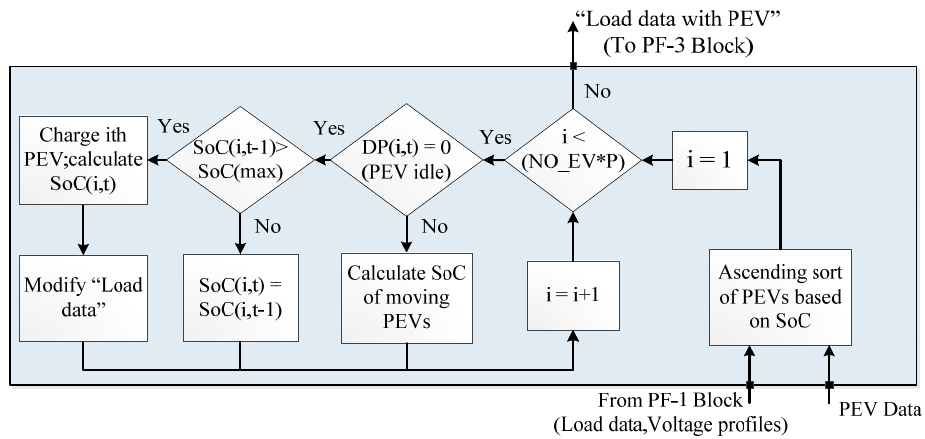
Figure 3. Charging pattern for plug ‐ in electric vehicles (PEVs) for each interval of simulation.